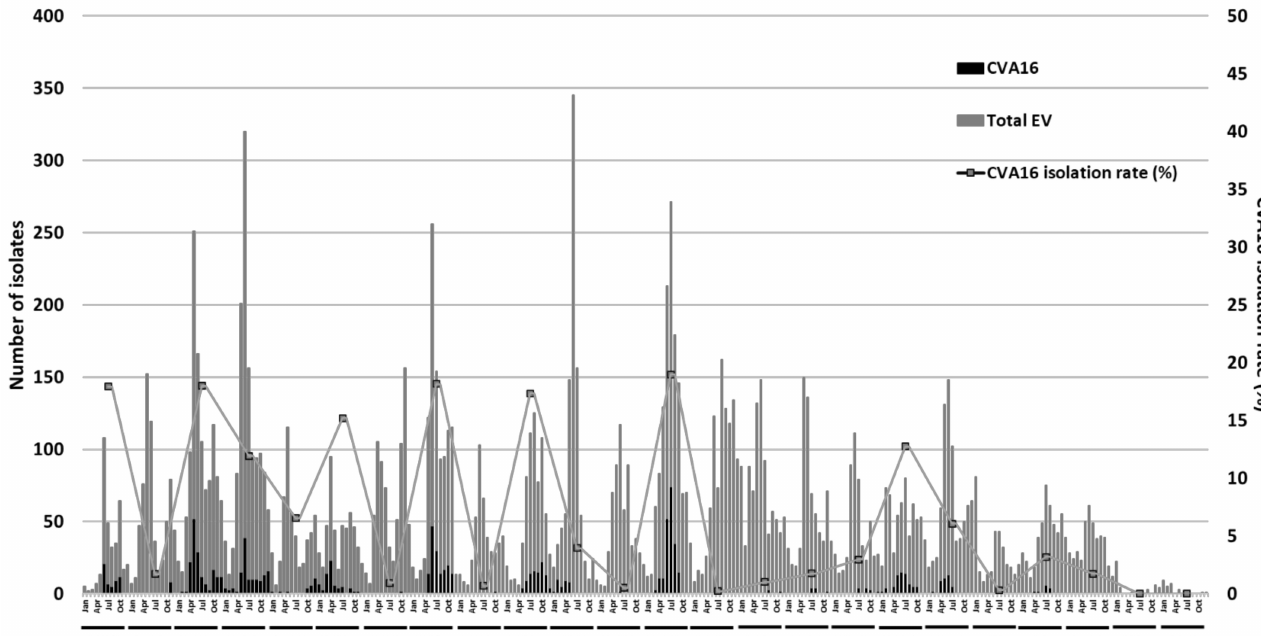
Figure 1. Monthly and yearly distribution of total enterovirus and CVA16 isolates in Southern Taiwan during 1998 to 2021. Numbers of total enterovirus isolates (grey column), CVA16 isolates (black column), and the CVA16 isolation rate (line graph) expressed.